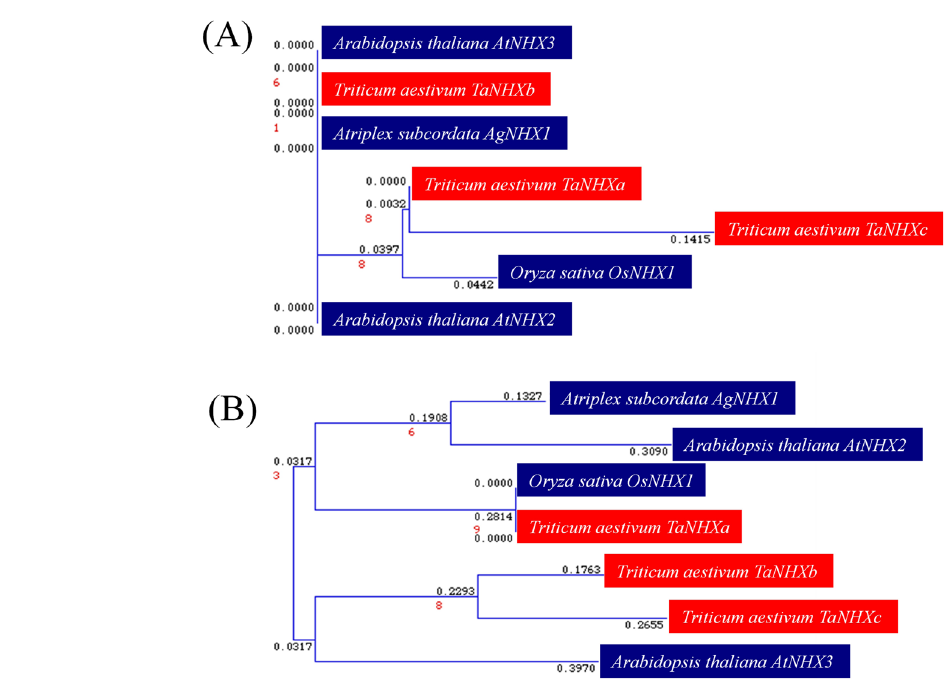
Figure 2 – Evolutionary tree of the 12 transmembrane domains that are characteristics of Na + /H + antiporter genes and among the regions between the transmembrane domains, (A) high homology in transmembrane domains among the species, (B) diversity in the regions between the transmembrane domains. When an evolutionary tree was created using the NJ method for the region between the 12 transmembrane domains that are characteristics of Na + /H + antiporter genes and transmembrane domains, the amino acid sequences of these regions were in good agreement between bread wheat ( TaNHXa , TaNHXb , TaNHXc ), rice ( OsNHX1 ), Atriplex subcordata ( AgNHX ) and Arabidopsis thaliana ( AtNHX2 , AtNHX3 , AtNHX4 ). Moreover, the amyloid binding sites were completely in agreement in all plants. Considerable differences were observed depending on the plant species in the regions between the transmembrane domains. However, TaNHXa of bread wheat showed a high degree of homogeneity with OsNHX1 of rice between domains and a close relationship on the whole.